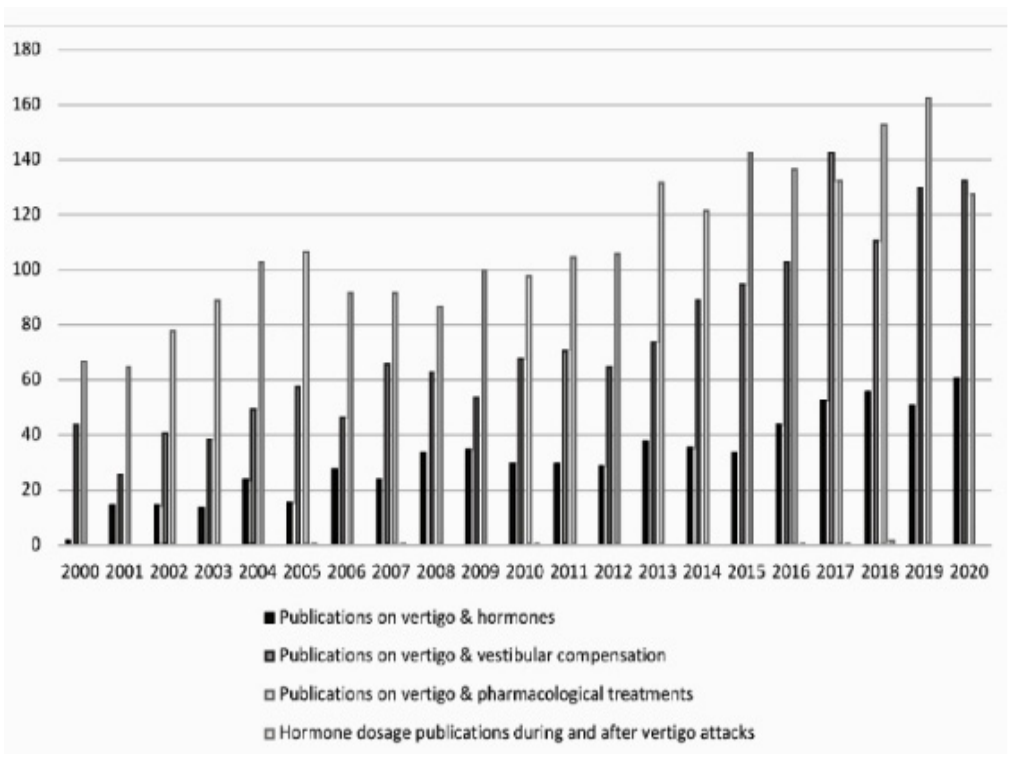
Figure 2. Comparison of the number of publications according to the different searched keywords. Period covered: 2001 to 2021. Horizontal axis: years; vertical axis: number of publications indexed on PubMed.